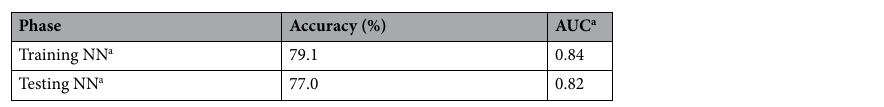
Table 4. Accuracy and AUC values in the training and test phase. a NN neural network, AUC area under the ROC curve.